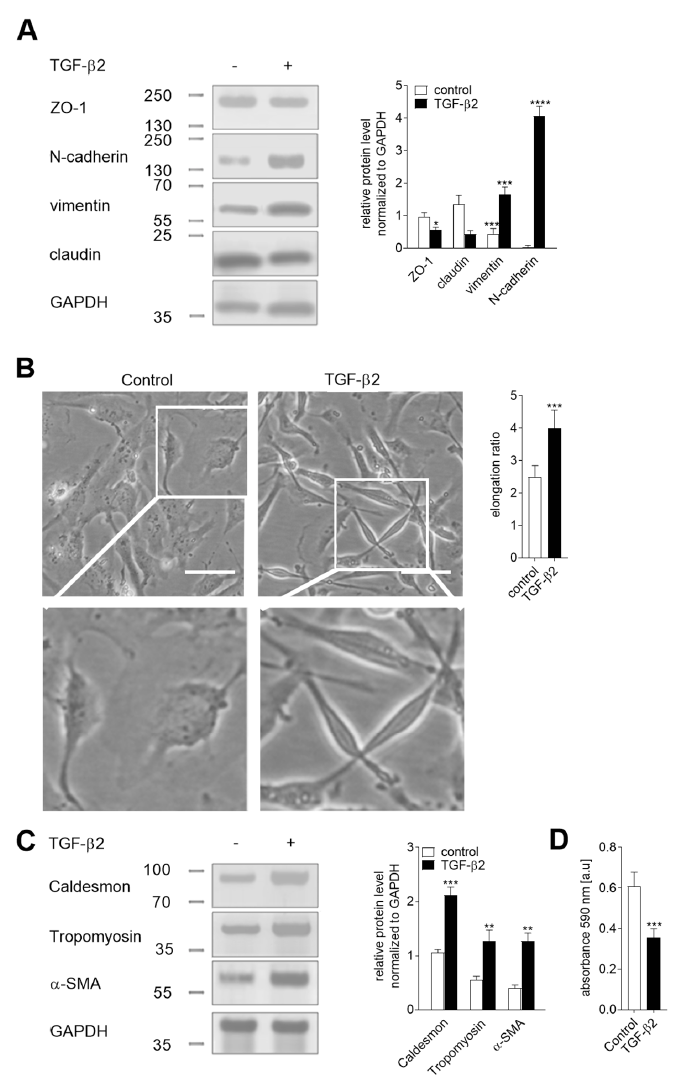
Figure 1. Characteristics of the TGF- β 2-induced endothelial–mesenchymal transition (EndMT) in HUVEC. Cells were incubated with TGF- β 2 (10 ng / mL) for 48 h or alone. Subsequently, ( A ) the level of EndMT markers was evaluated using Western blot assay with the appropriate antibodies. The background was subtracted and the area for each protein peak was determined. Protein levels were normalized to GAPDH. ( B ) Cell morphology was observed under the microscope. Representative images are shown and a quantitative analysis of the mean of elongation ratio from three independent experiments was performed in Meta®Morph. Bars, 30 μ m. ( C ) Contraction markers were determined by Western blot analysis. The relative protein level was quantified using scan densitometry. The background was subtracted and the area for each protein peak was determined. Protein levels were normalized to GAPDH. Subsequently, ( D ) the adhesion properties to collagen I was analyzed. Cells were placed on a collagen I pre-coated well for 1 h to adhere. After washing, the cells were stained, and the total cell-associated protein was determined using a microplate reader at 595 nm. The results are presented as the means ± SD ( N = 3); * p < 0.05, ** p < 0.01, *** p < 0.001, **** p < 0.0005.